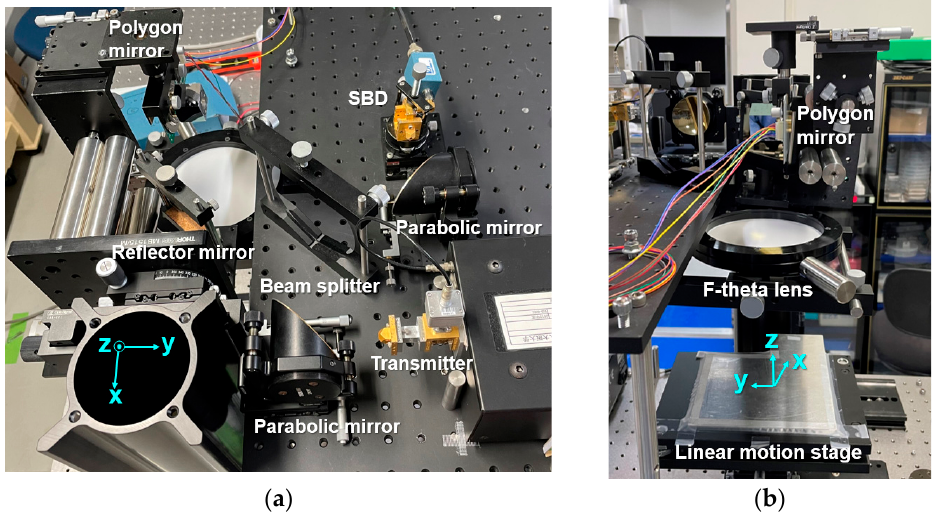
Figure 3. Experimental setup of the high-speed imaging system. ( a ) Vertical view of the experimental setup. (SBD: Schottky barrier diode.) ( b ) Overview of the experimental setup.